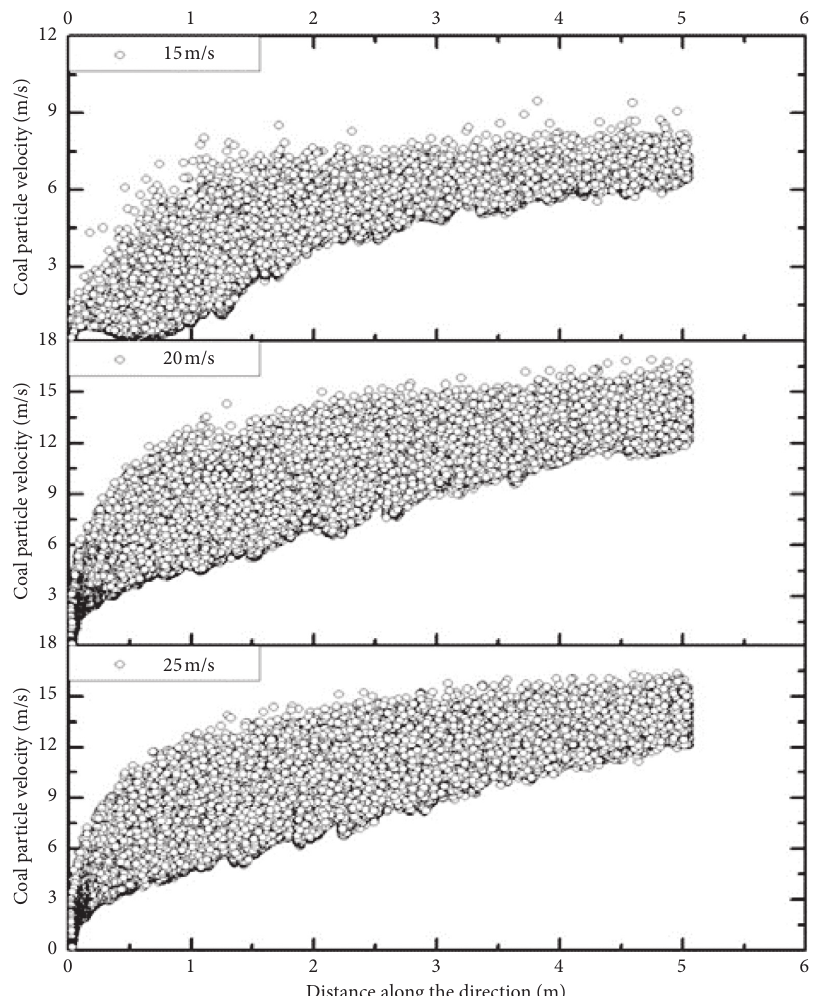
Figure 12: Coal particle velocity distribution along the flow direction with particle generation rate of 0.02kg/s ( t �